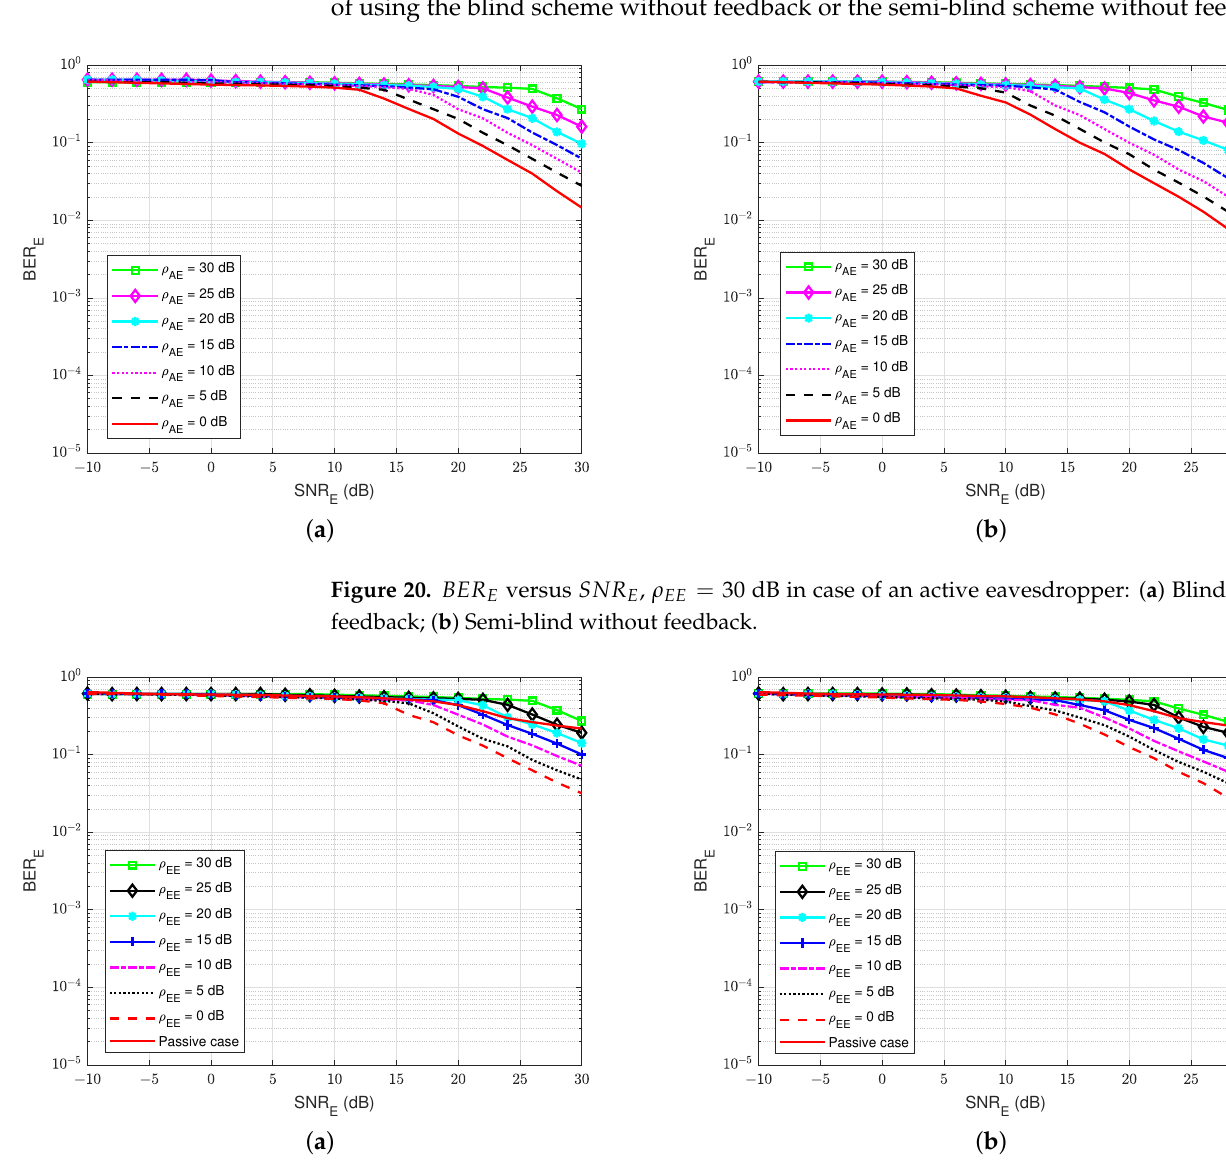
Figure 21. BER E versus SNR E , ρ AE = 30 dB in case of an active eavesdropper: ( a ) Blind without feedback; ( b ) Semi-blind without